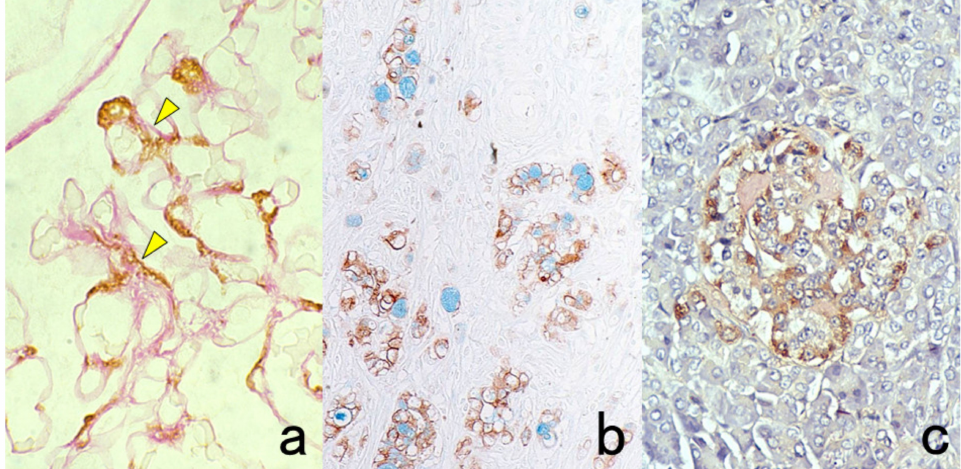
Figure 4. Double labeling of immuno- and conventional staining. ( a ): IgA and PAS in renal biopsy of IgA nephropathy. The PAS-reactive basement membrane surrounds mesangial deposition of IgA visualized after prolonged trypsin digestion (arrowheads). ( b ): Carcinoembryonic antigen (CEA) and alcian blue in gastric signet ring cell carcinoma. CEA expression of mucin-containing cancer cells appears weaker. ( c ): Insulin and Congo red in a pancreatic islet in type 2 diabetes mellitus. Orange-colored amyloid deposition is seen among the insulin-positive β